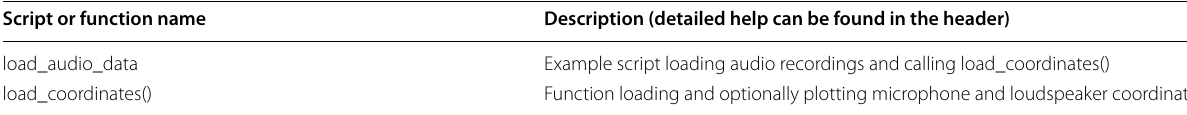
Table 5 Scripts facilitating the use of the database Script or function